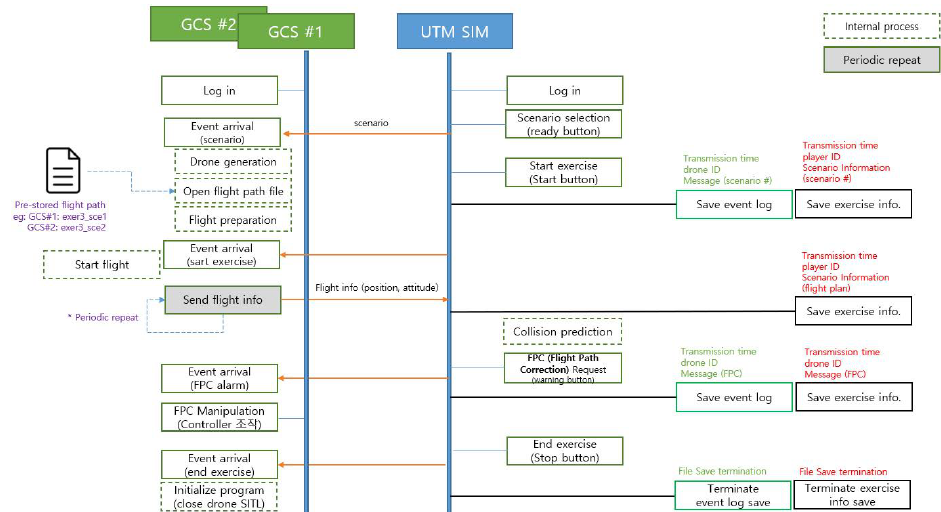
Figure 15. Scenario #3 (emergency by unexpected drone flights).